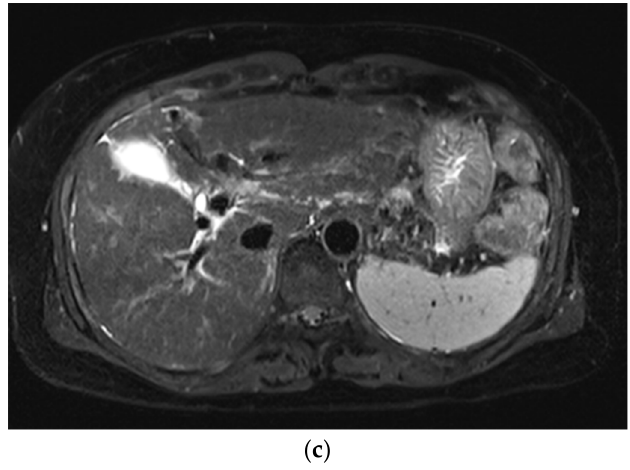
Figure 2. Comparison of sharpness of organ margin in three T2WIs acquired on Skyra. SSFSE CONV ( a ) was rated 2, mTSE ( b ) was rated 5, and SSFSE CS ( c ) was rated 4. The visibility of peripheral vessel or duct was rated highest for mTSE (5), followed by SSFSE CS (4) and SSFSE CONV (2). Table 2. Results of subjective image analysis using five ‐ point evaluation scale system for each MRI sequence.